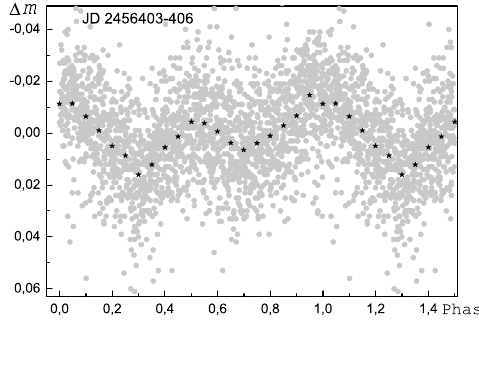
Figure 4: Phase light curve of early